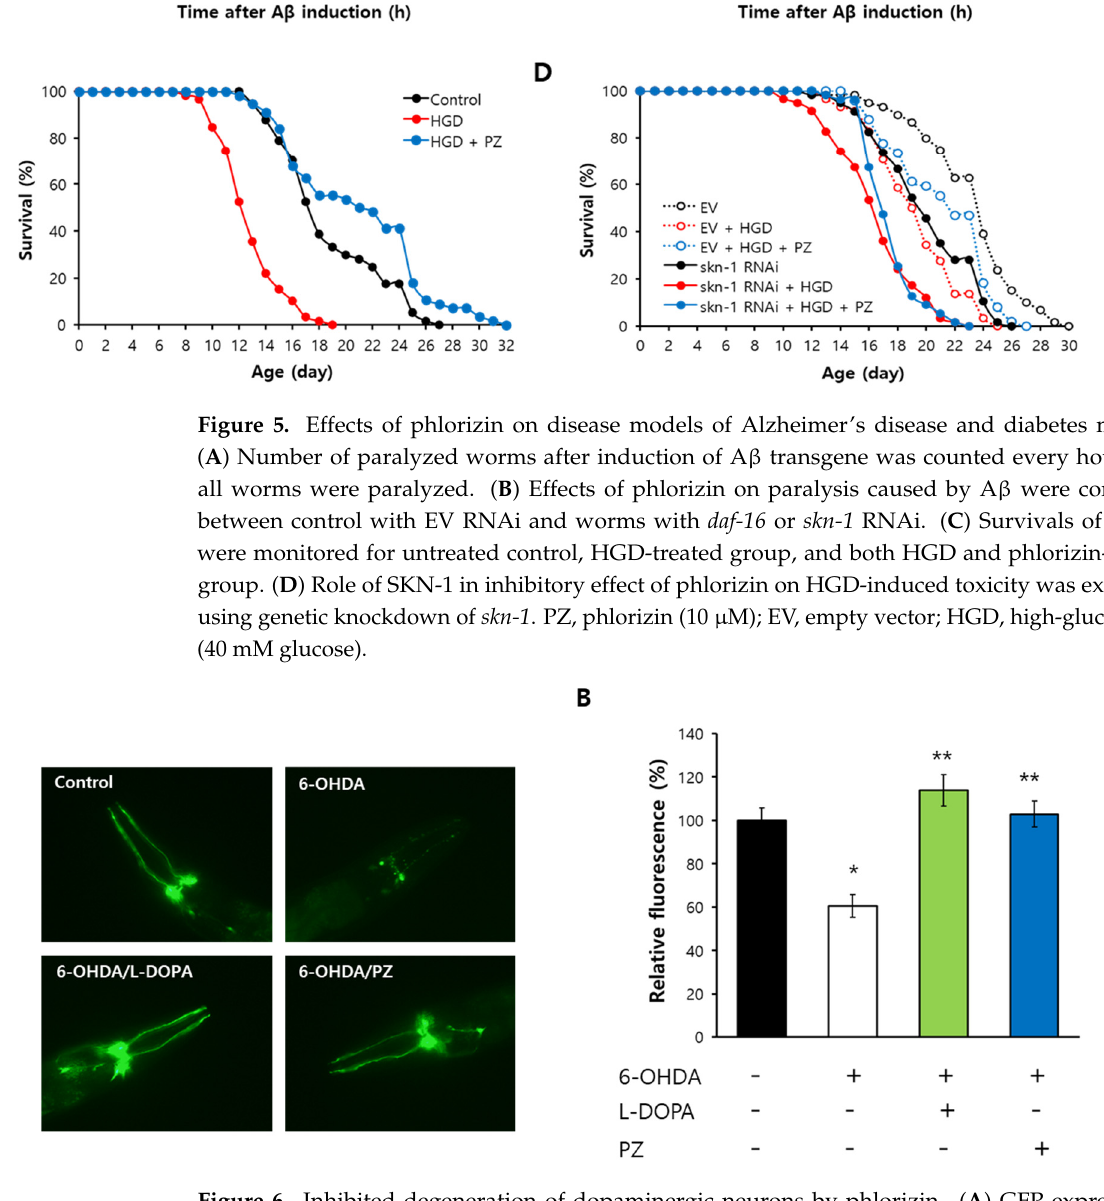
three mutants representing each known genetic pathway leading to lifespan extension were employed. The lifespan of age-1 , a long-lived mutant due to reduced insulin/IGF-1- like signaling, was not changed after treatment with phlorizin. Mean lifespan of age-1 was 29.7 d in the untreated control and 30.7 d in the group of age-1 treated with phlorizin ( p = 0.254) (Figure 7A). In the clk-1 mutant, in which ROS production was reduced by dysfunc- tional mitochondria to induce a long lifespan, phlorizin failed to increase lifespans. Mean lifespans were 19.5 and 18.7 d for untreated control and phlorizin-treated groups of clk-1 , respectively ( p = 0.163) (Figure 7B). The eat-2 mutation is a genetic model of DR. DR retards aging and age-related physiological changes in many model organisms [9,10]. The mean lifespan of eat-2 (20.4 d) was not affected by phlorizin treatment (18.6 d, p = 0.898) (Figure 7C). Taken together, no additional lifespan extension of long-lived mutants suggests that the lifespan-extending effect of phlorizin overlaps with that of each genetic pathway. We then examined the role of specific factors common to those lifespan-extending pathways. The phlorizin-induced longevity observed in the wild-type N2 completely disappeared when the expression of daf-16 was repressed. Mean lifespans of N2 with daf-16 RNAi (12.9 d) and N2 with daf-16 RNAi and phlorizin treatment (12.8 d) were not significantly differ- ent ( p = 0.941) (Figure 7D). The effect of lifespan extension by phlorizin was also abolished by genetic knockdown of bec-1 , a worm homolog of a human autophagic gene. Mean lifespans were 18.9 and 18.5 d in N2 with bec-1 RNAi and N2 with bec-1 RNAi and phlorizin treatment, respectively ( p = 0.724) (Figure 7D and Table S6). Since DAF-16 mod- ulates the response to oxidative stress and BEC-1 is a key factor regulating autophagy, we analyzed the effect of phlorizin on expression of genes involved in oxidative stress re- sponse and autophagy. Among four oxidative stress-responsive genes tested, expression levels of ctl-1 and sod-3 as downstream targets of DAF-16 were significantly increased af- ter supplementation with phlorizin (1.4- and 1.5-fold increase in mRNA levels of ctl-1 ( p = 0.016) and sod-3 ( p = 0.027), respectively) (Figure 8). Expression levels of skn-1 and gst-4